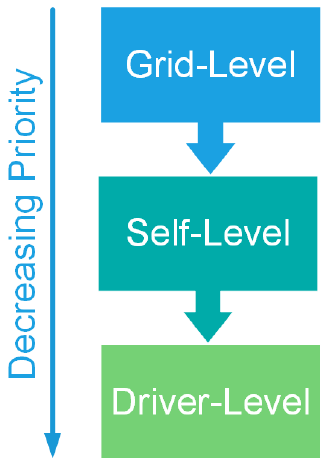
Figure 5. H-DCCB protection flow chart.